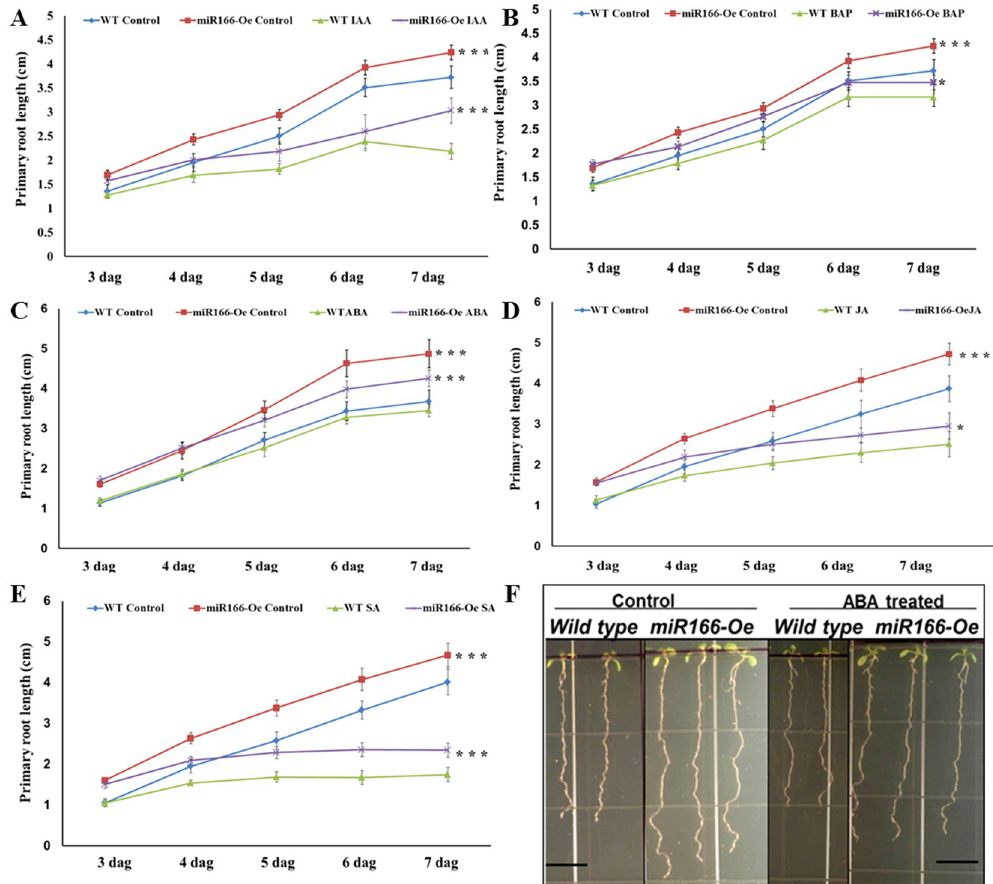
Figure 4. Phytohormones affect the root growth of miR166-Oe and wild type plants. Primary root growth of miR166-Oe in the presence of ( A ) 0.1 µ M IAA, ( B ) 0.1 µ M BAP, ( C ) 1 µ M ABA, ( D ) 20 µ M JA, and ( E ) 100 µ M SA. The primary root length measurement was done using Image J software from 3 dag to 7 dag. Error bars indicate ± SD (n = 10). One-way ANOVA was performed. Statistically significant differences are indicated as, * for P < 0.05, ** for P < 0.01 and *** for P <